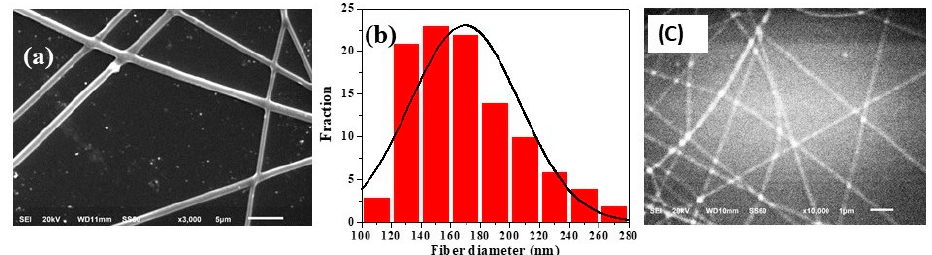
Figure 2. ( a ) SEM image of as-spun Zn 2 Y fibers, ( b ) fiber diameter distribution for as-spun fibers, and ( c ) SEM image of Zn 2 Y fibers annealed at 1000 °C.